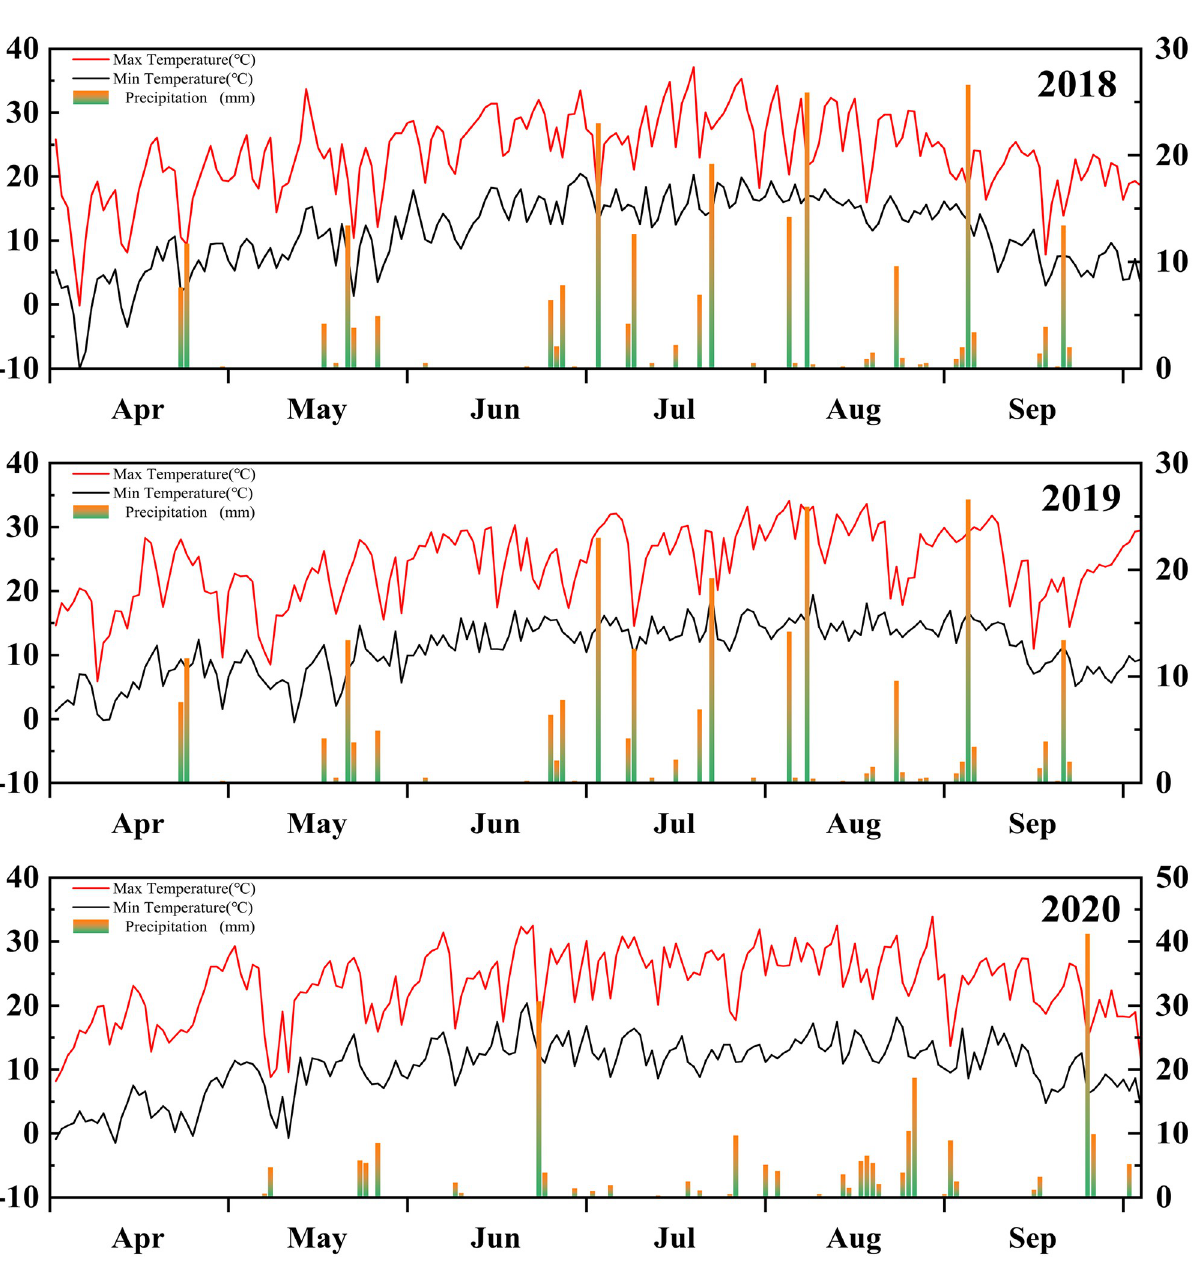
Fig 1. The precipitations (indicated by the bars) and the max and min daily temperatures (indicated by the curves) of the experimental sites in the growing season of the silage corn in 2018, 2019, 2020.